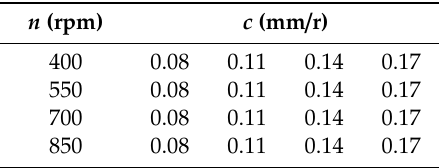
Table 1. Cutting parameters for Experiment I.